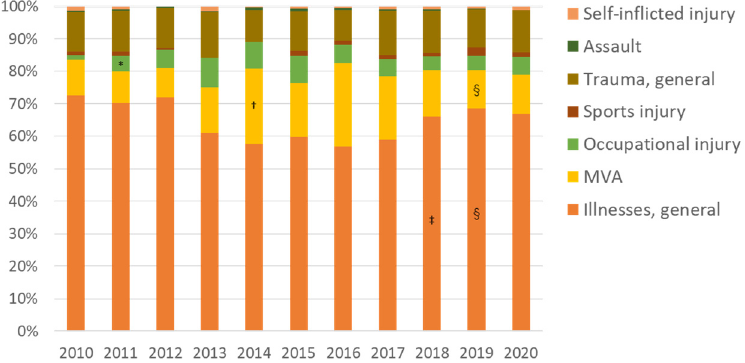
Figure 5. Proportion of injuries and illnesses among patients transported by ambulance before and after the Fukushima accident (2011). MVA, motor vehicle accident. * p < 0.001 vs. 2010; † p = 0.002 vs. 2013; ‡ p = 0.006, § p < 0.001 vs. 2017. The proportion of occupational injuries increased four-fold in 2011 compared with before the accident (*). Traffic injuries increased after the evacuation order of Kawauchi Village was lifted in 2014 (†). In 2018, the proportion of endogenous diseases increased compared with 2017 (§).